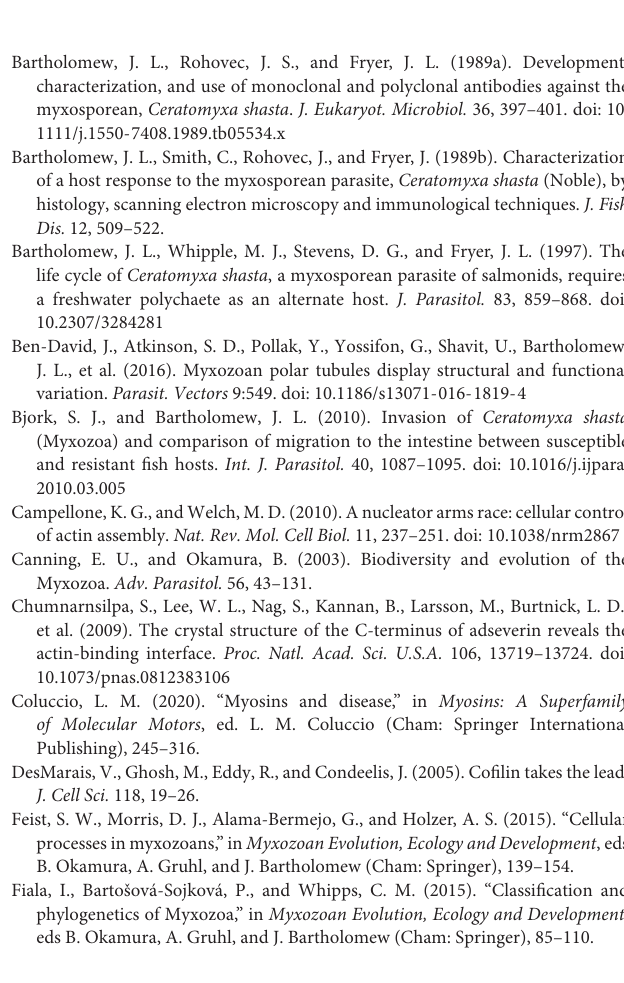
Supplementary Table 1 | List of proteins identified in the study including annotation and proteomic data. Supplementary Table 2 | Protein sequence of the identified proteins. Supplementary Table 3 | List of proteins shown in Figure 3 . Supplementary Table 4 | GO analysis data in Figure 4